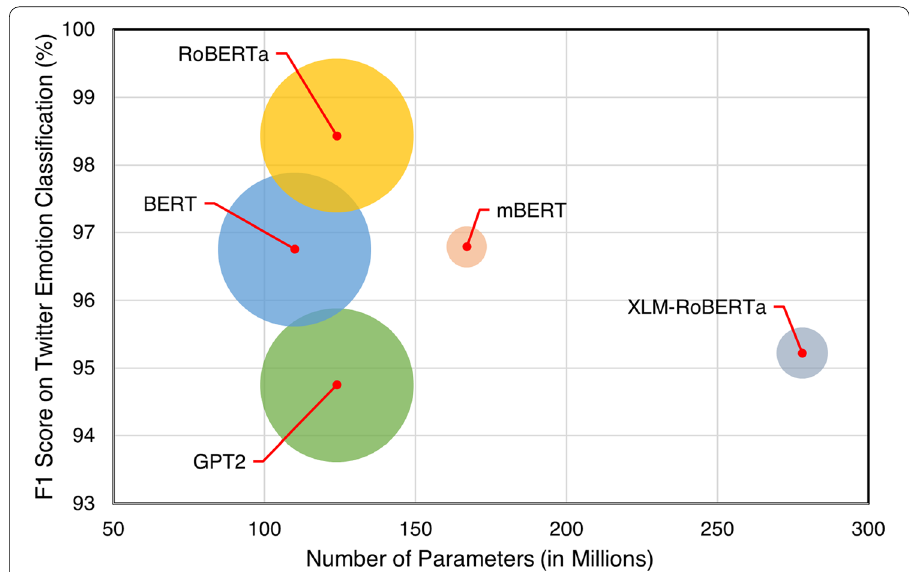
Fig. 2 Downstream performance of Sundanese and multilingual models on tweet emotion classification in terms of their number of parameters. The area of the points corresponds to their pre-training corpus size (in million